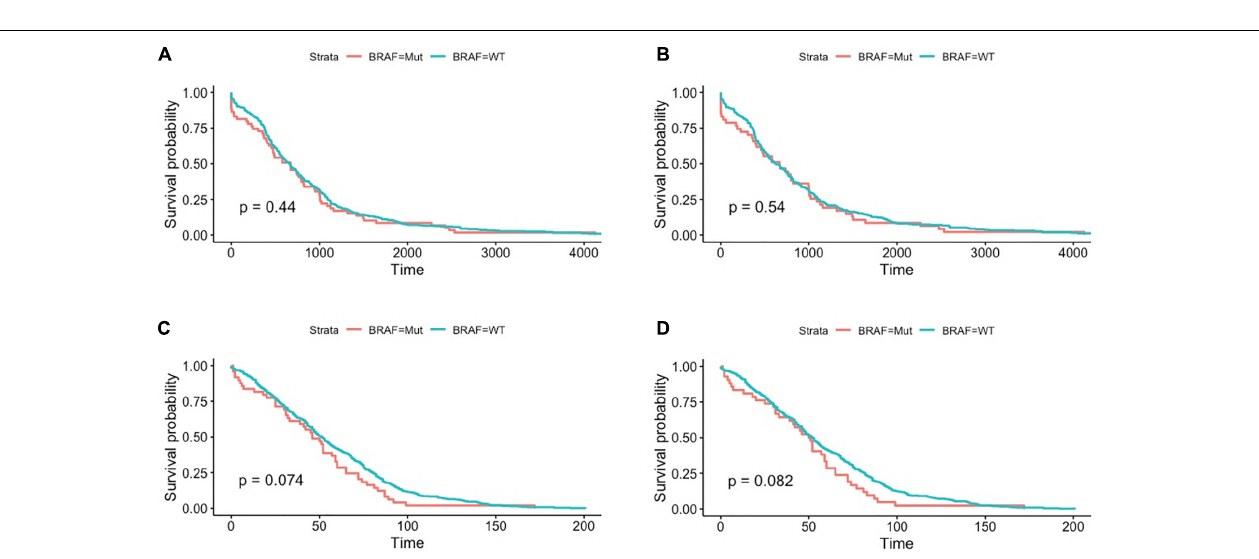
FIGURE 1 | BRAF mutation in colon cancer is presented with significantly different stromal scores, immune scores, ESTIMATE scores, and tumor purity in the TCGA dataset (A) and GEO dataset (B) . Student’s t -tests were used for all analyses.